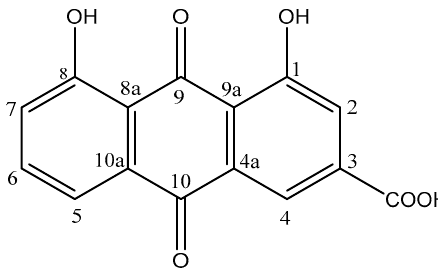
Figure 1. Chemical structure of rhein.